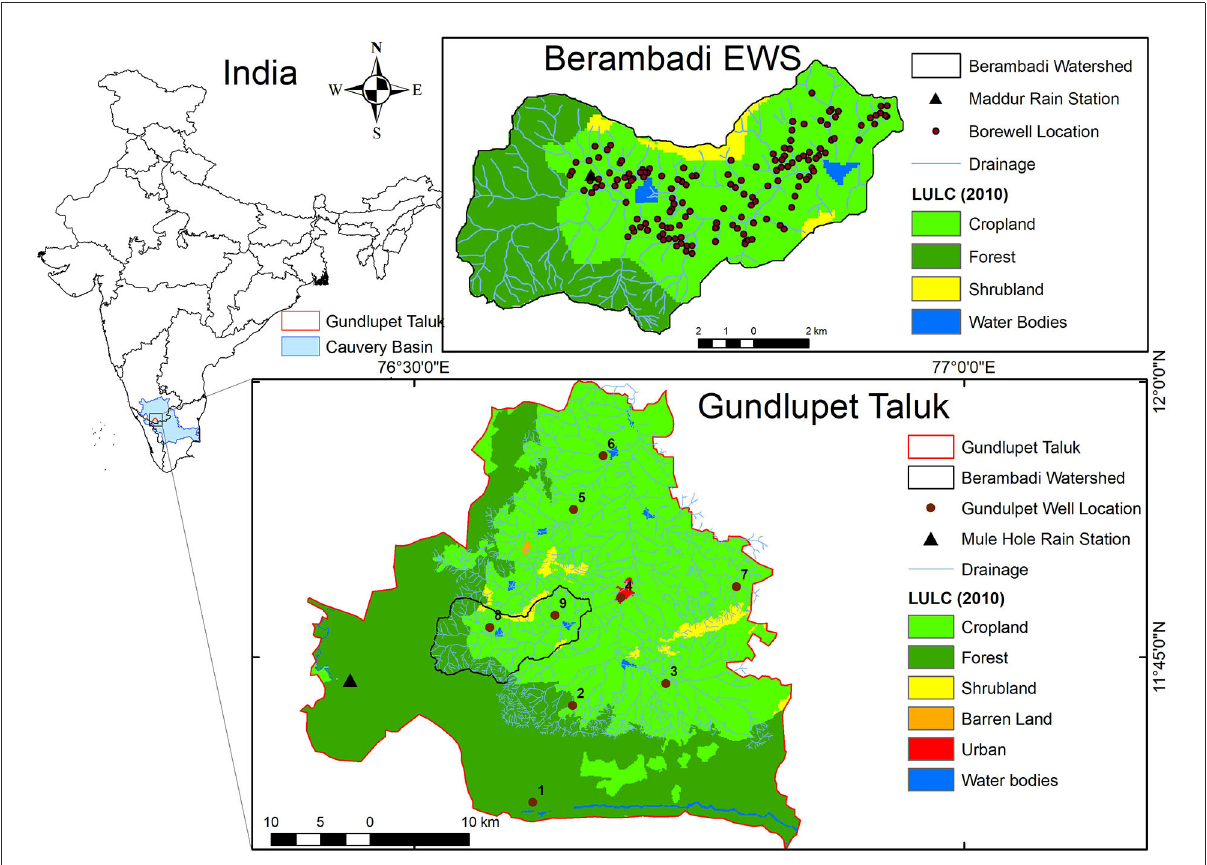
FIGURE1 Location of groundwater observation wells in Gundlupet taluk and Berambadi